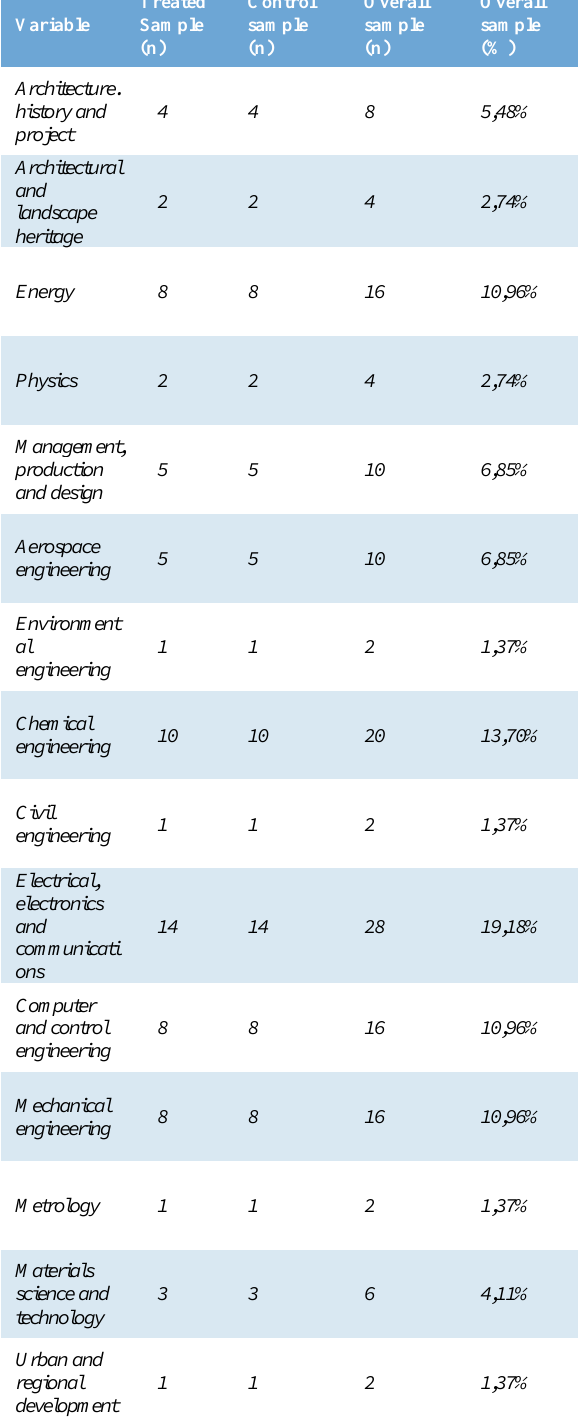
Table 2. Percentage of PhDs according to their doctoral